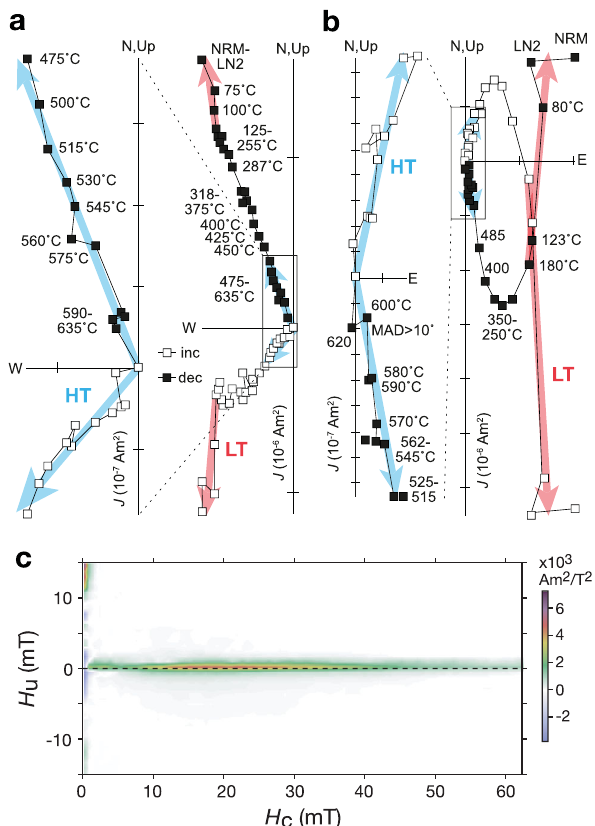
Fig. 1 Magnetization of the Scaglia Rossa limestone. a , b Orthogonal vector diagrams of typical demagnetization behavior with low-temperature (LT) components and insets with magni fi ed views of high-temperature (HT) components. NRM natural remanent magnetization, LN2 liquid nitrogen immersion. a Normal polarity sample (FUR2-136) from Furlo section. Steps after signi fi cant loss in magnetization >575 °C were excluded from least-squares fi t. b Reversed polarity sample (C10AD34) from Apiro section. Steps >590 °C with circular standard deviation (CSD) > 10° were excluded from least-squares fi t. c First-order reversal curve (FORC) distribution exhibiting a “ central ridge ” indicating the magnetic mineral assemblage of the Scaglia Rossa limestone is dominated by highly stable, single-domain, biogenic magnetite magnetofossils. San Severino locality, near the main Apiro section. See Methods for experiment